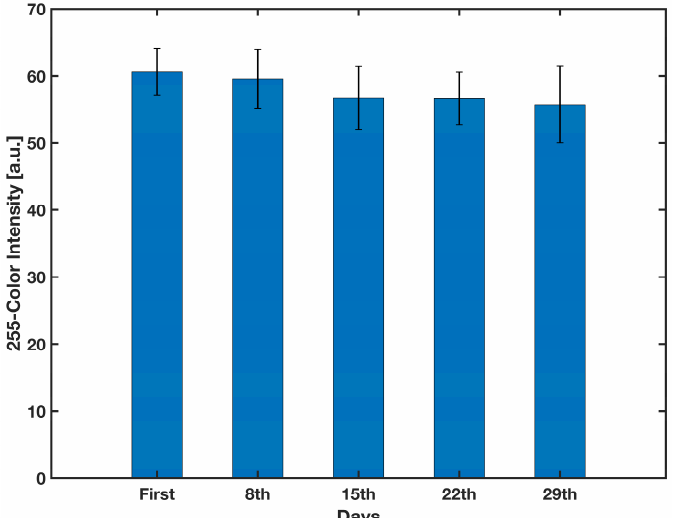
Figure 9. Effect of time on the color intensity formed on the detection zone. n = 5 and the error bars represent the standard deviation.